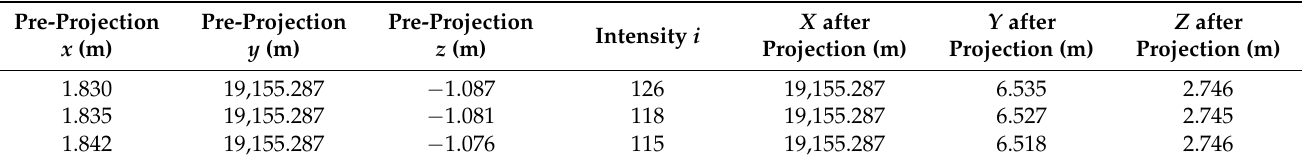
Table 1. Post-projection data